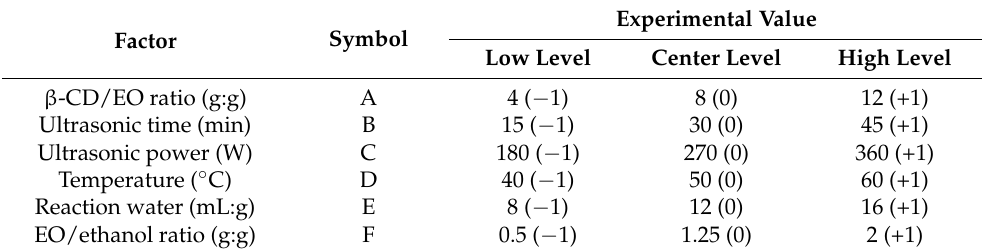
Table 4. Levels of the factors tested in